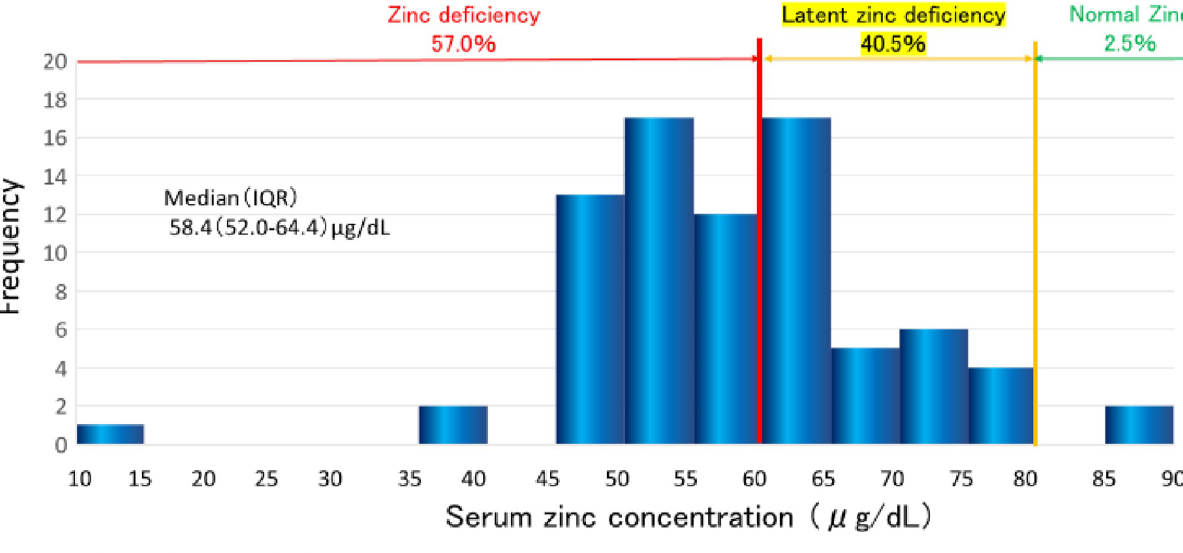
Fig 2. Distribution of serum zinc